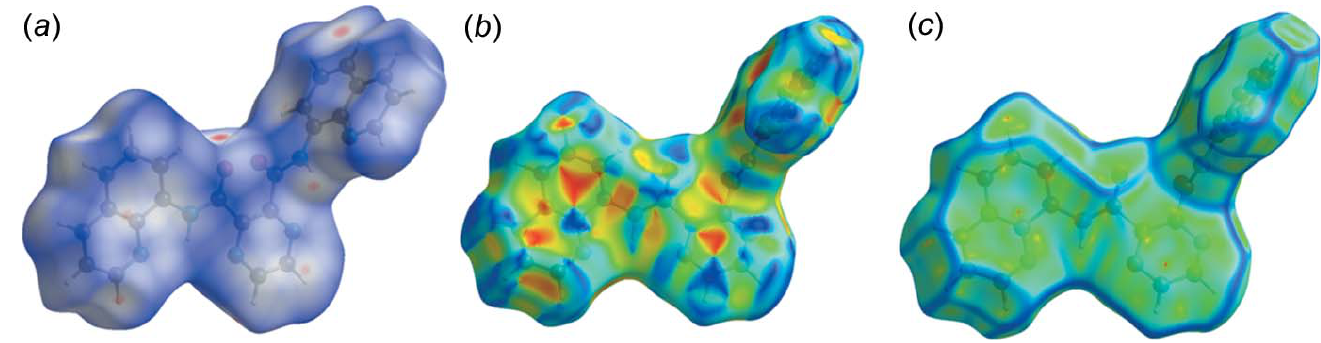
Figure 8 ( a ) Aview of the Hirshfeld surface for H 2 L1 mapped over d norm , with colour code (cid:4) 0.1884 to 1.1906 a.u., ( b ) a view of the Hirshfeld surface mapped over the shape-index for H